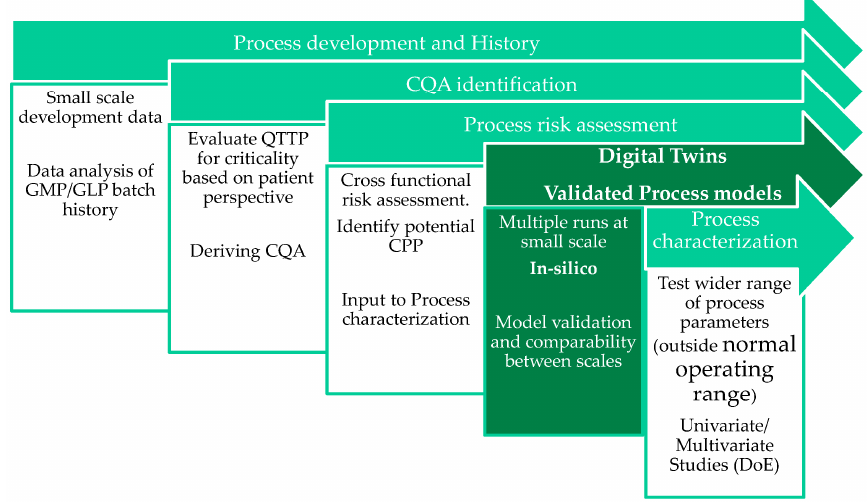
Figure 1. Models as part of process development [21].